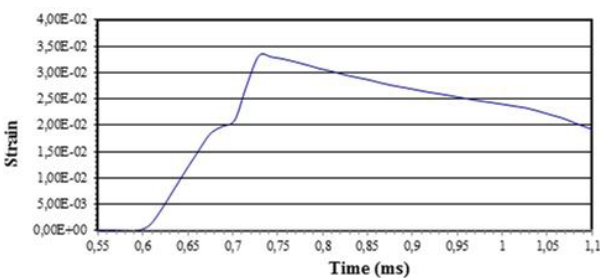
Figure 7. Strain-time curve in the centre of the specimen when us- ing SiC-reinforced ZC71 magnesium alloy at − 5000mms − 1